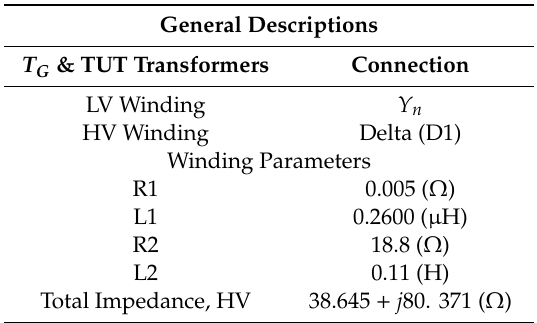
Table 1. Specification of T G (general transformer) and TUT transformers.